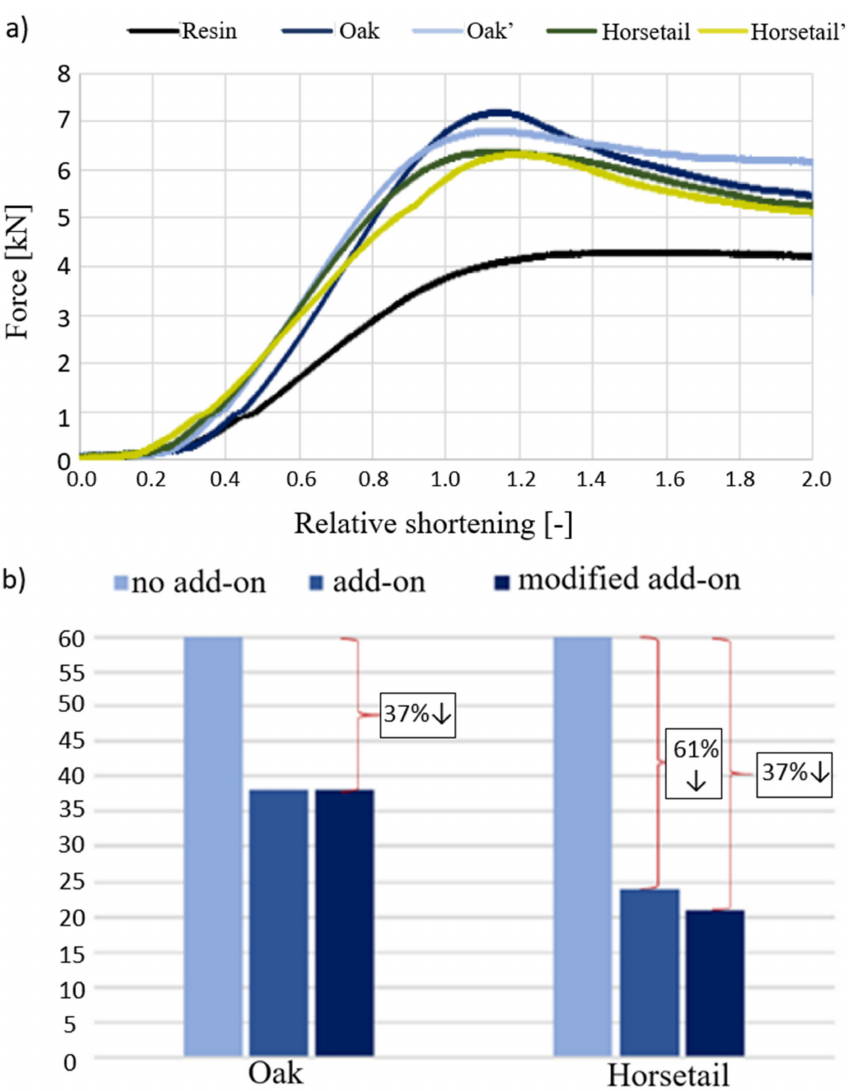
Figure 18. Compression force dependence on relative shortening for samples with modified additives ( a ) and impact strength of materials with modified additives ( b